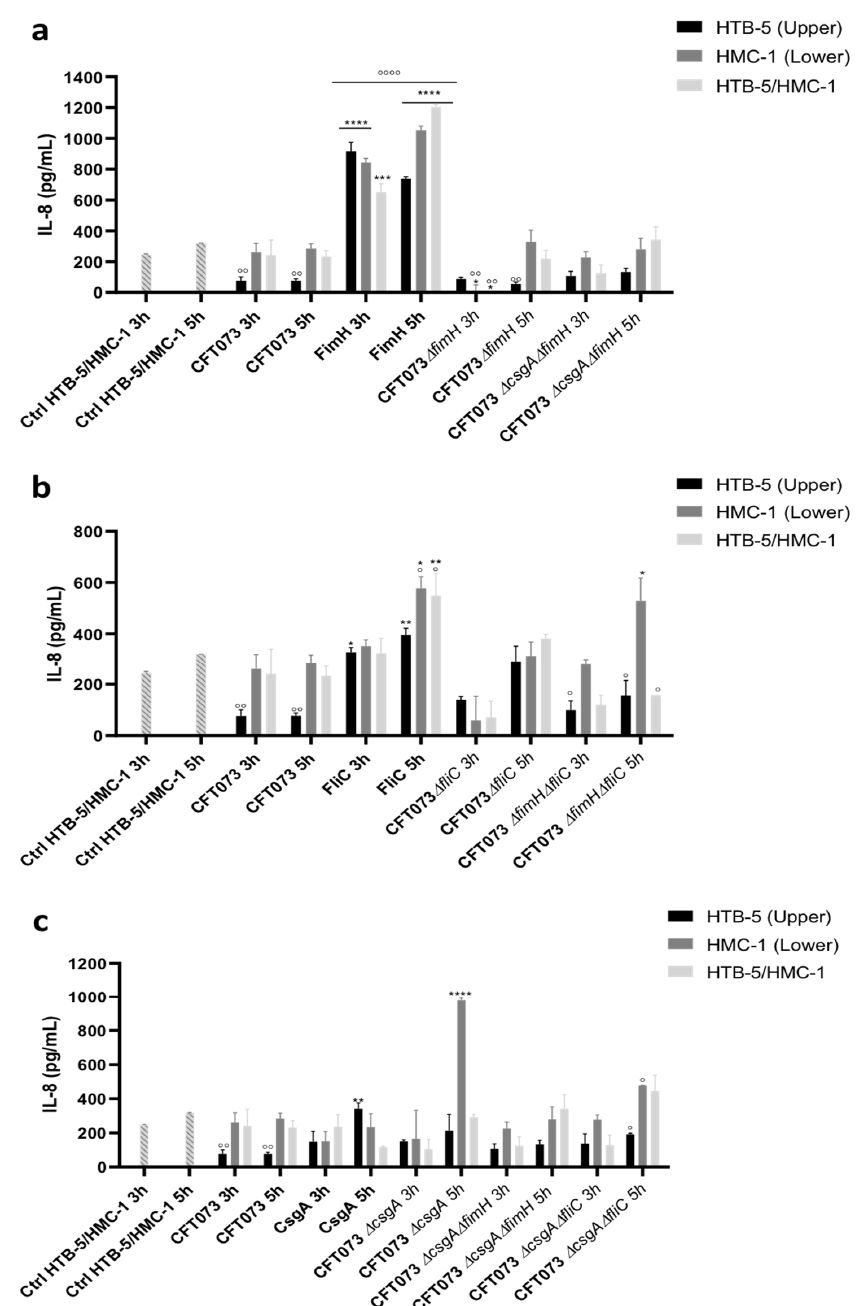
HMC-1 cells and simultaneously infected HTB-5/HMC-1 cells (Figure 2b). HMC-1 cells infected with the CFT073 ∆ fimH ∆ fliC strain showed an increase in IL-8 release compared with those infected with the CFT073 strain at 5 h (Figure 2b).